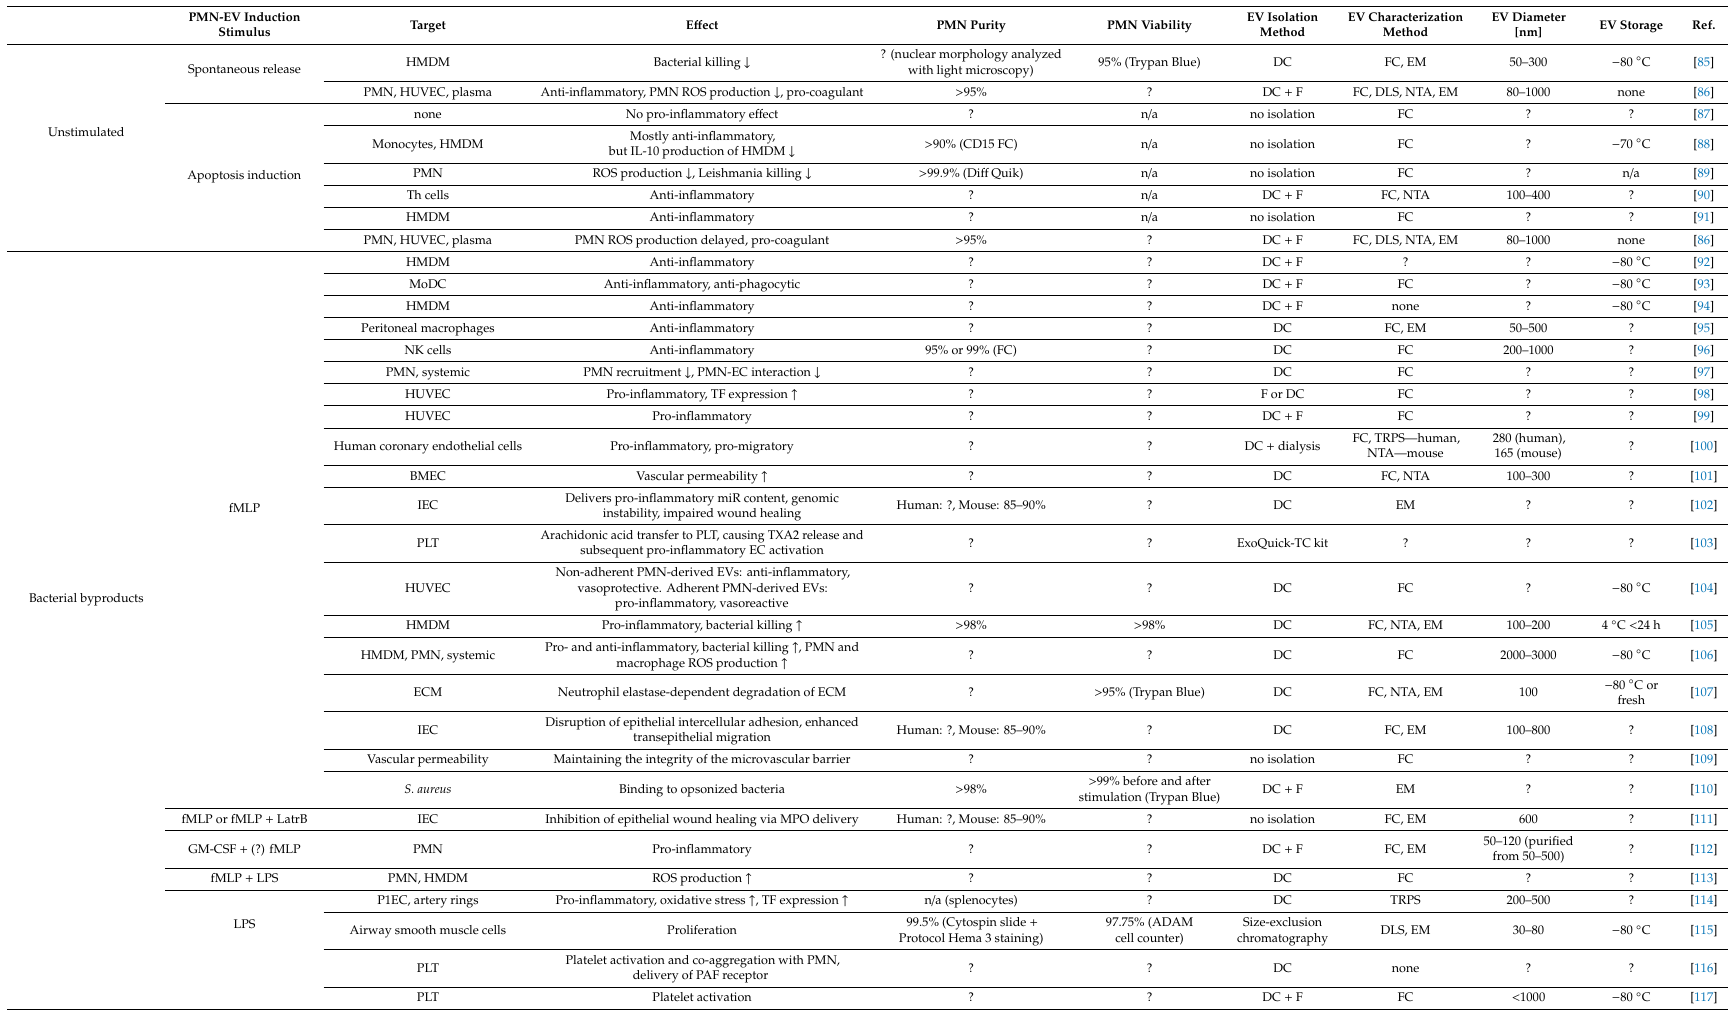
Table 1. Overview of publications studying the biological function of neutrophil-derived EVs (extracellular